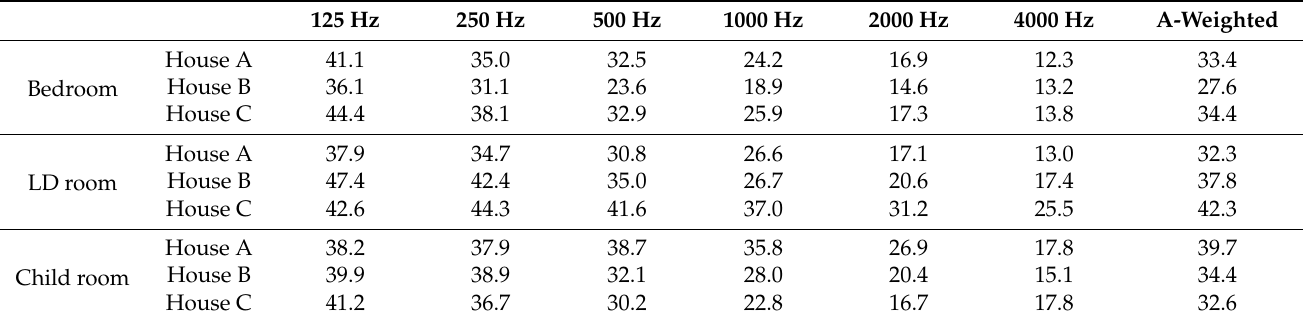
Table 11. Background noise levels (dB) in nine rooms in modern Japanese